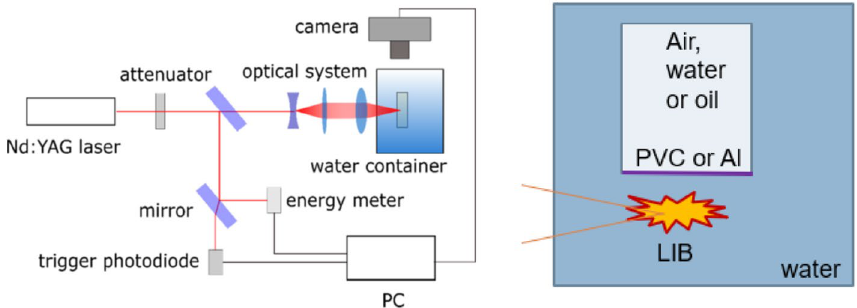
Figure 1. Experimental